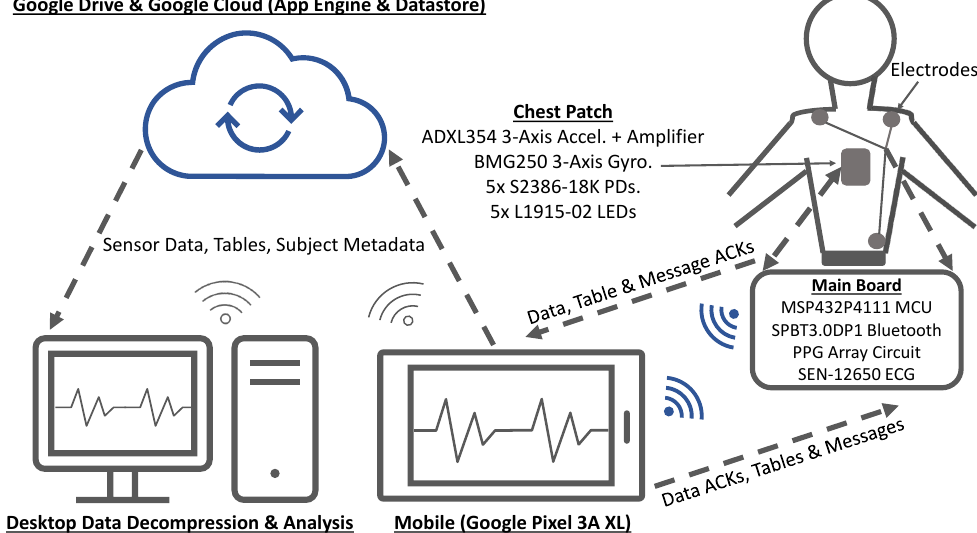
Figure 7. Block diagram for the experimental